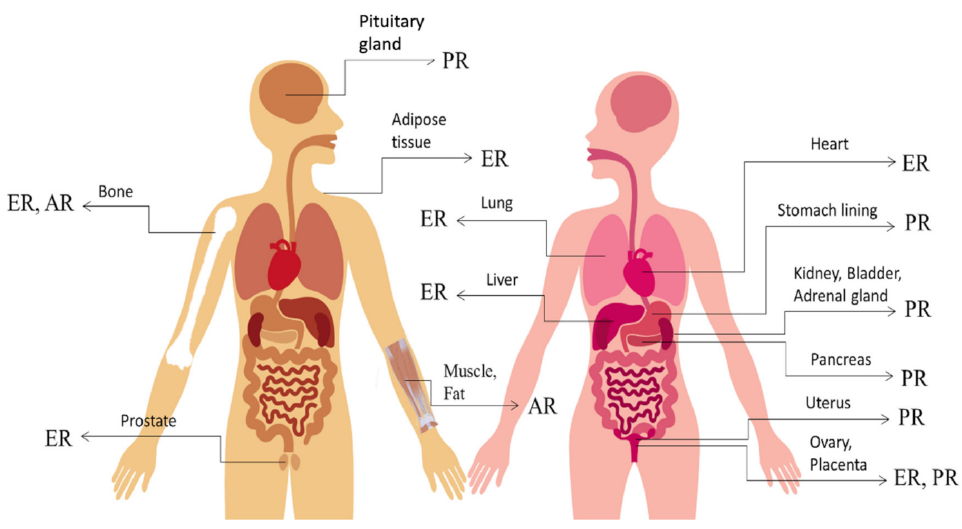
Figure 1. Distribution of sex steroid hormone receptors in males and females. ER: oestrogen receptor; PR: progesterone receptor; AR: androgen